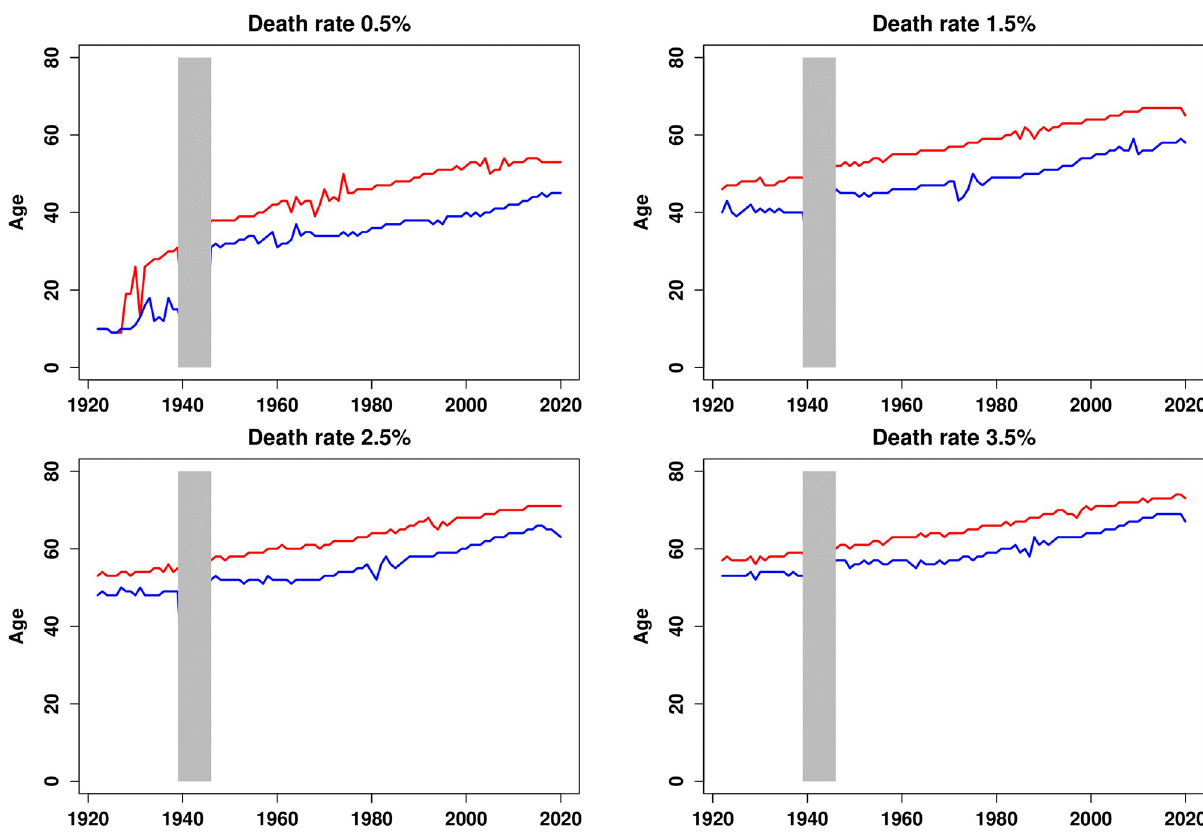
Fig 3. Ages at which 4 mortality milestones are reached, 1922–2020. Plain curves plot the ages that correspond to the mortality threshold considered. Men are in red and women are in blue. Ages are not represented for the period 1939–1945.